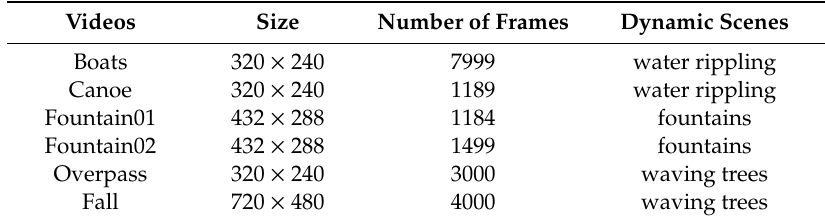
Table 3. Dynamic background